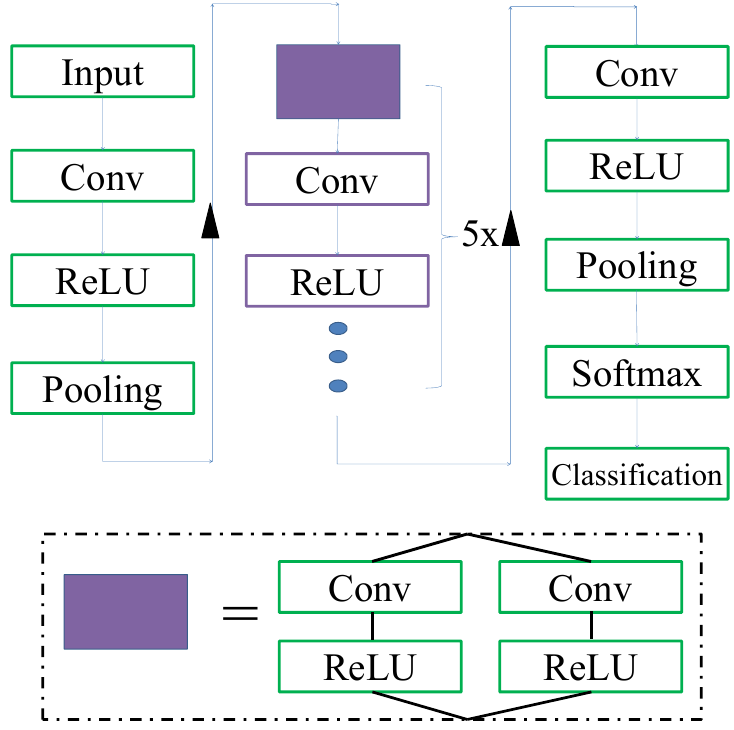
Figure 2. The SqueezeNet architecture.